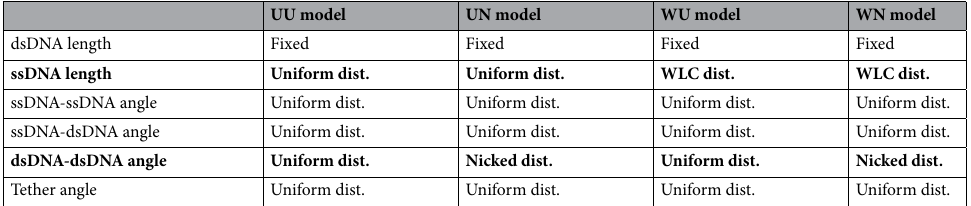
Table 1. Summary of the different biophysical model parameterizations investigated in this work. All four models use identical distributions for dsDNA domain lengths, ssDNA-ssDNA domain angles, ssDNA-sdDNA domain angles and tether angles. They differ only in the choices made for ssDNA domain lengths and dsDNS- dsDNA domain angles, highlighted in boldface in the table. “WLC dist.” refers to the worm-like chain model of length distributions of jointed chains. “Nicked dist.” refers to a distribution of inter-domain angles at a nick “joint between two dsDNA domains linked only on one strand” that was previously reported 4 . All distributions are described in detail in the main